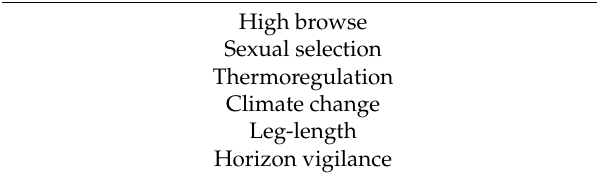
Table 1. Explanations for giraffe neck elongation and stature (modified from Wilkinsons and Ruxton 2011,